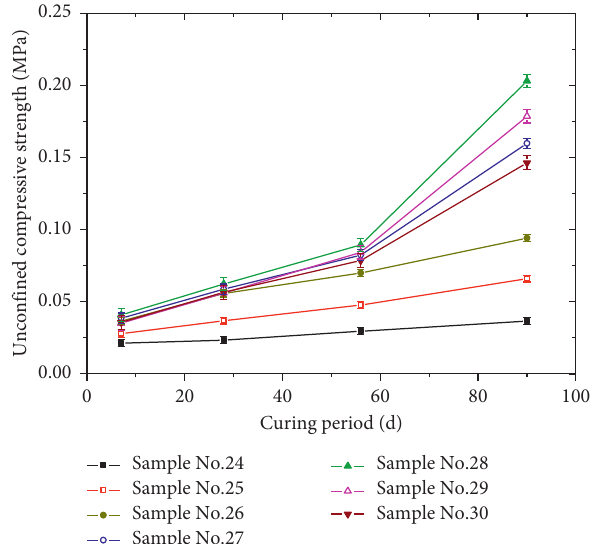
Figure 17: Influence of curing period on UCS of samples stabilised with Na